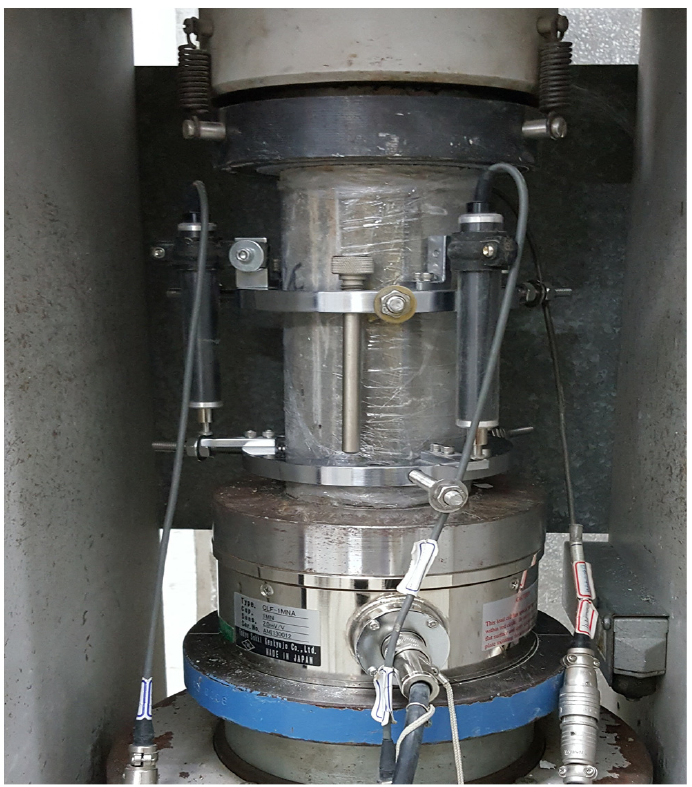
Figure 6. Elastic modulus of concrete cylinder setup with two strain rings.